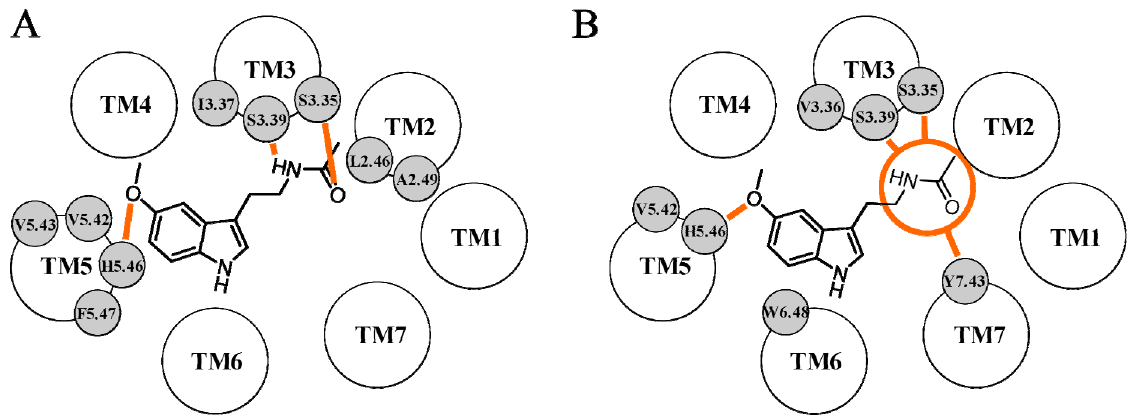
Figure 8. Representation of the binding scheme of melatonin proposed by Voronkov et al. ( A ) and Chugunov et al. ( B ) within the MT binding site. Hydrogen bond interactions are 2 depicted with orange lines. The orange circle represents potential hydrogen bond interactions between the amide group of melatonin and residues 3.35, 3.39 and